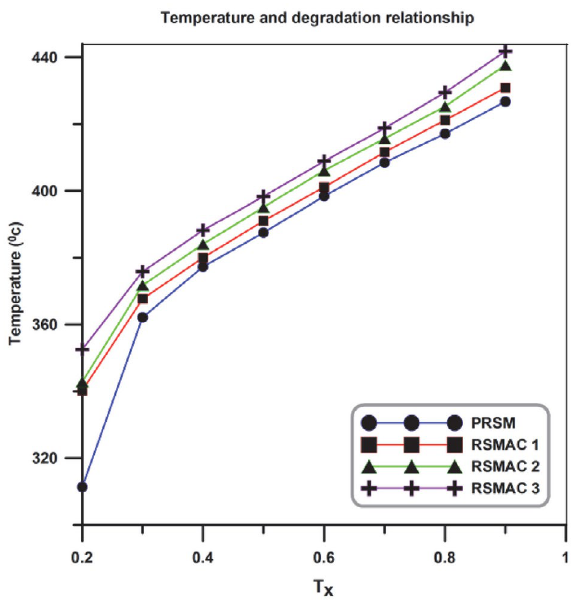
Figure 11. Graphical illustration of temperature and degradation